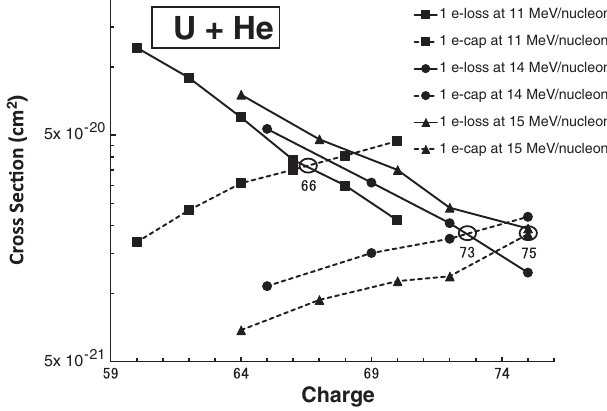
FIG. 5. Measured cross sections of e-loss and e-capture as a function of charge state of uranium ions at 11, 14, and 15 MeV = nucleon in He gas. The cross sections were extracted assuming the thickness of the gas cell to be 13 : 27 (cid:1) g = cm 2 . The intersections between the two lines for the cross sections of e- loss and e-capture are indicated by the circles with the corre- sponding numbers of ion charge below.